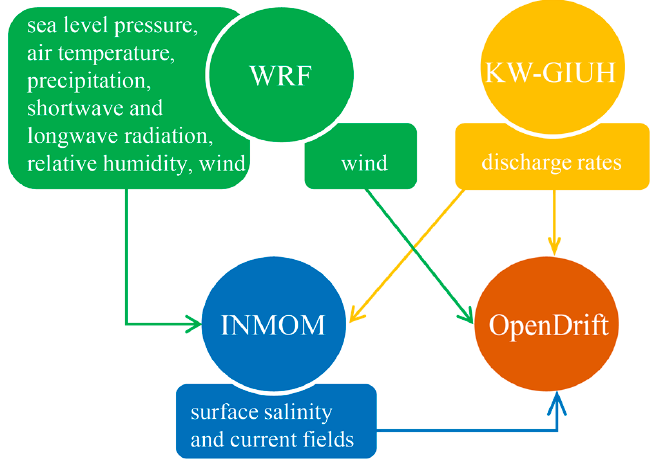
Figure 4. Flowchart of the models interaction.